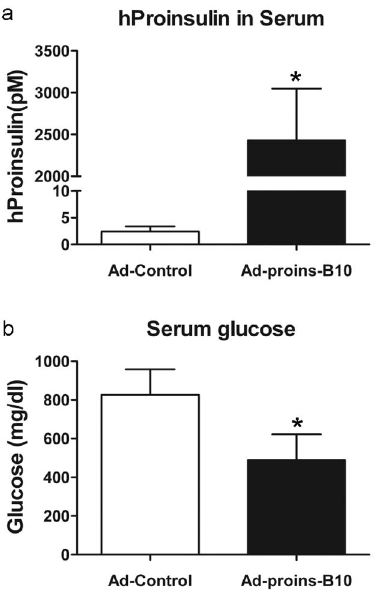
Figure 6. Endocrine secretion of hProinsulin from SMGs transduced with rAd-proinsulin-B10 significantly reduces blood glucose in ALX-diabetic mice. Both SMGs of ALX-diabetic mice were transduced with 5 6 10 9 particles of either rAd-Control (empty vector) or rAd-proinsulin-B10. Sera were collected 24 h later. ( a ) ELISA analysis of hProinsulin (pM) in serum, *P=0.0003 vs. rAd-Control. ( b ) Serum glucose levels, *P=0.036 vs. rAd-Control. For all panels, bars indicate mean + SEM for n=7 animals per treatment group. Statistical significance was determined by unpaired Student t test followed by Mann-Whitney post hoc